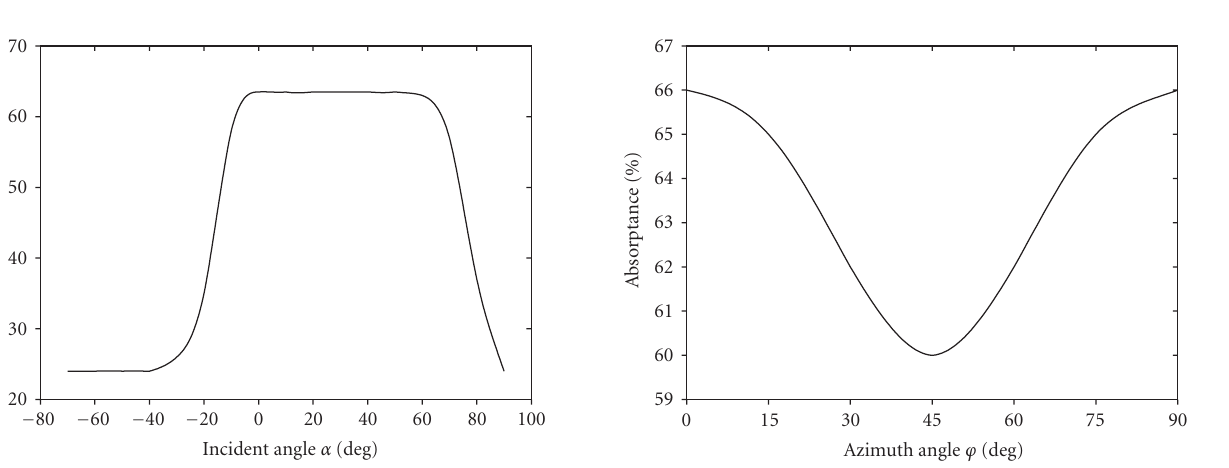
Figure 5: The relation of absorptance and incident angle.